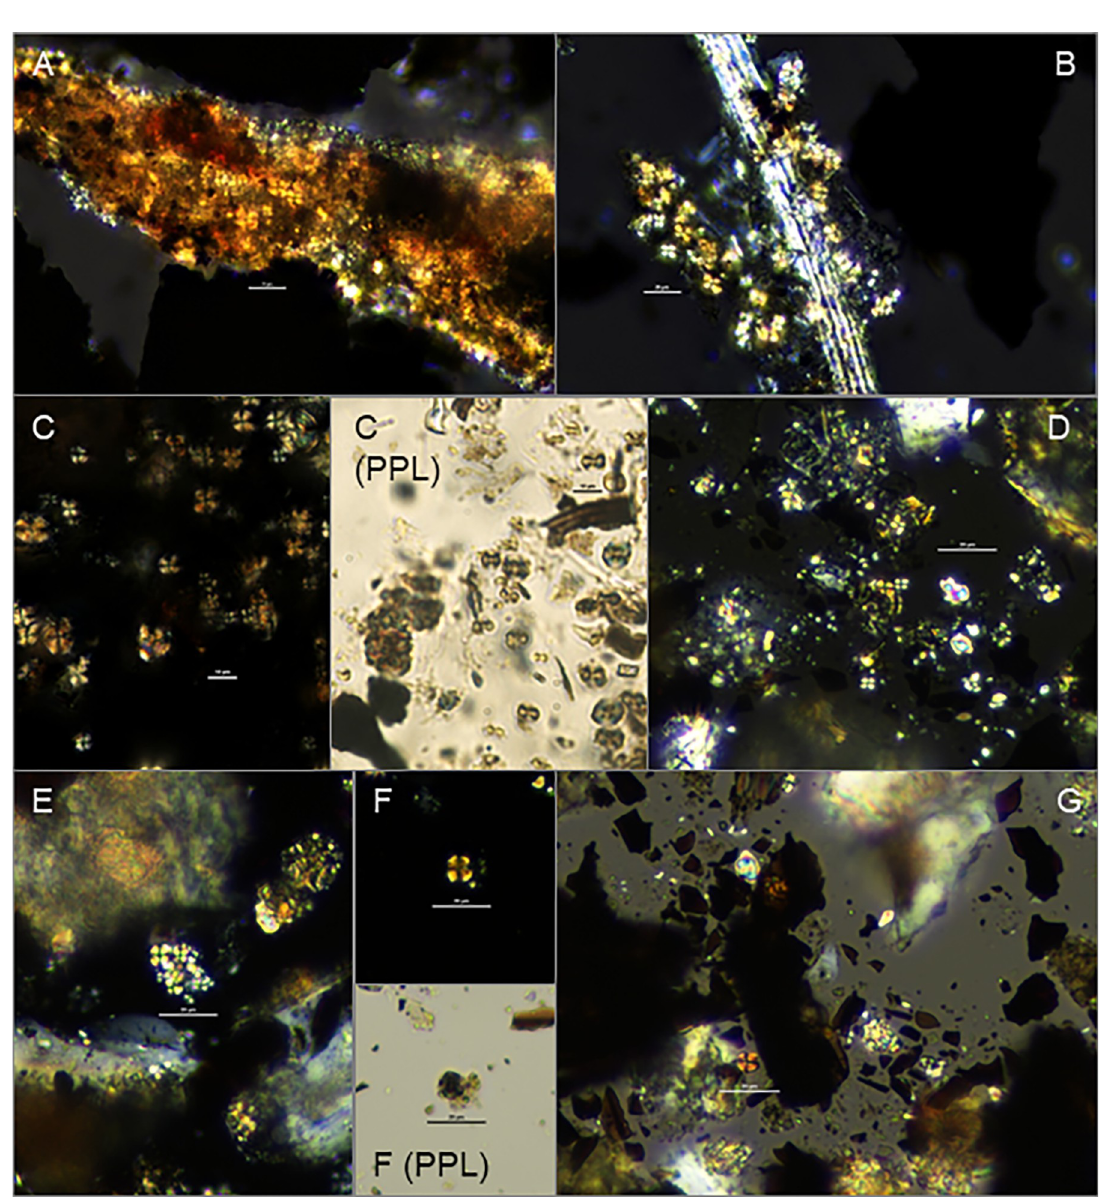
Fig 5. Photographs of spherulites documenting: A) and B) examples of spherulite clusters surrounding plant-based fibers within surface samples from Abu Hureyra known to be contaminated with modern dung (D,72,87 and D,73,95 respectively); C) modern sheep ( Ovis aries) dung charred at 600˚C for 2 hours revealing several large darkened spherulites indicating burning; D) general view of remains recovered from phase 2A/B plaster floor (E,369,73/225) rich in spherulites; E), F), G) a cluster of spherulites, an example of a darkened spherulite, and examples of isolated spherulites surrounded by abundant wood charcoal fragments respectively, all from Epipalaeolithic 1B firepit (E,427,73/283). Scale bar = 20 μ m in all images except for C, where bar = 10 μ m. Images taken using cross-polarized light; PPL in images C and F indicates same view in plane polarized